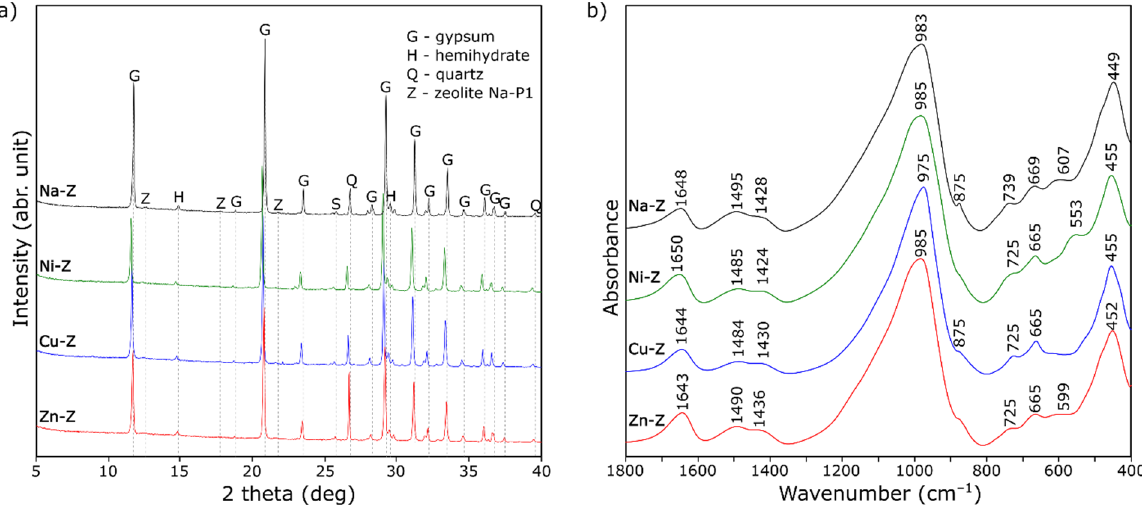
Figure 4. X-ray diffraction patterns ( a ) and FT-IR spectra ( b ) of gypsum composites with lightweight aggregates containing zeolite impregnated with various ions.